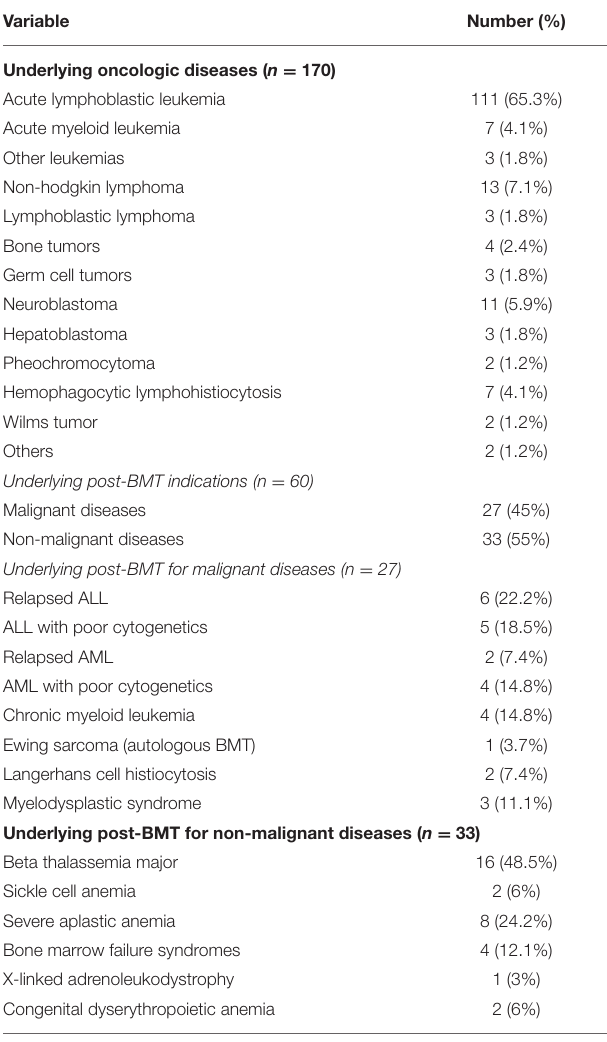
TABLE 2 | Diseases associated with